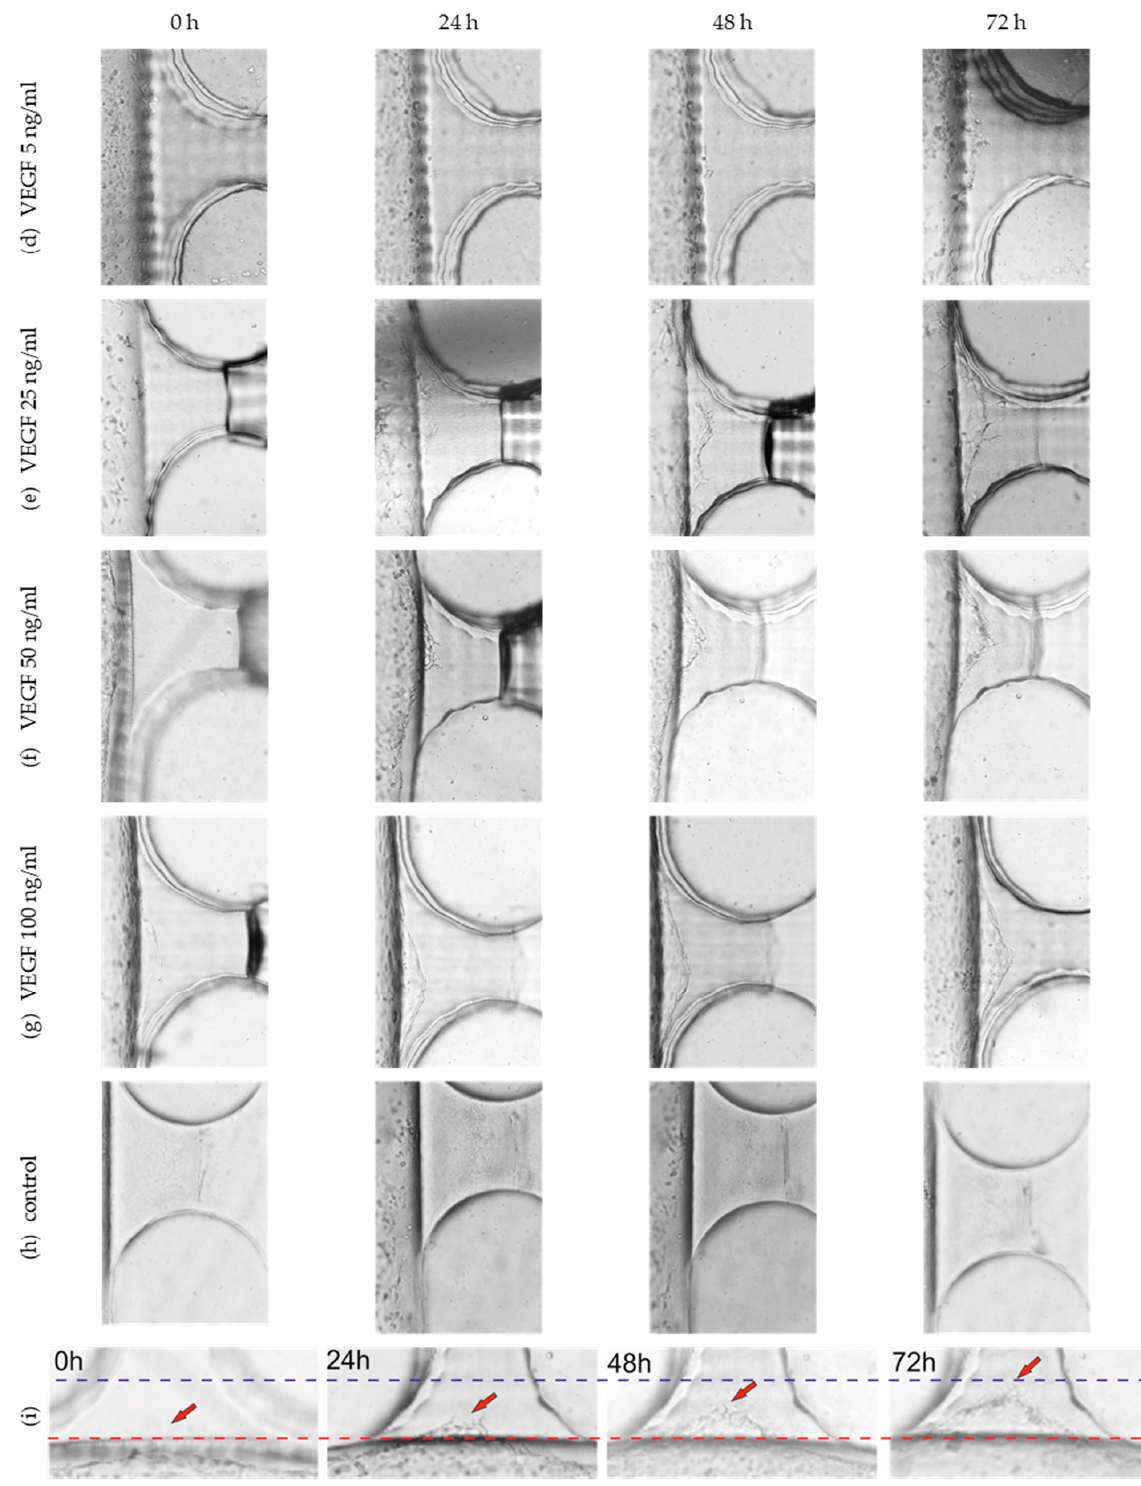
Figure 5. ( a ) Ready-to-use microplatform 3 consisting of PDMS bonded with a coverslip glass. ( b ) Structure of migrating port. ( c ) Quantitative and ( d – h ) qualitative analysis over influence of VEGF’s concentration on migration of HUVECs. ( i ) One-factor analysis (VEGF with concentration of 50 ng/mL) of sprout length at different time points. Arrows point to end of sprout. All images were taken with the use of fluorescence microscopy. Scale bar: 100 µm.